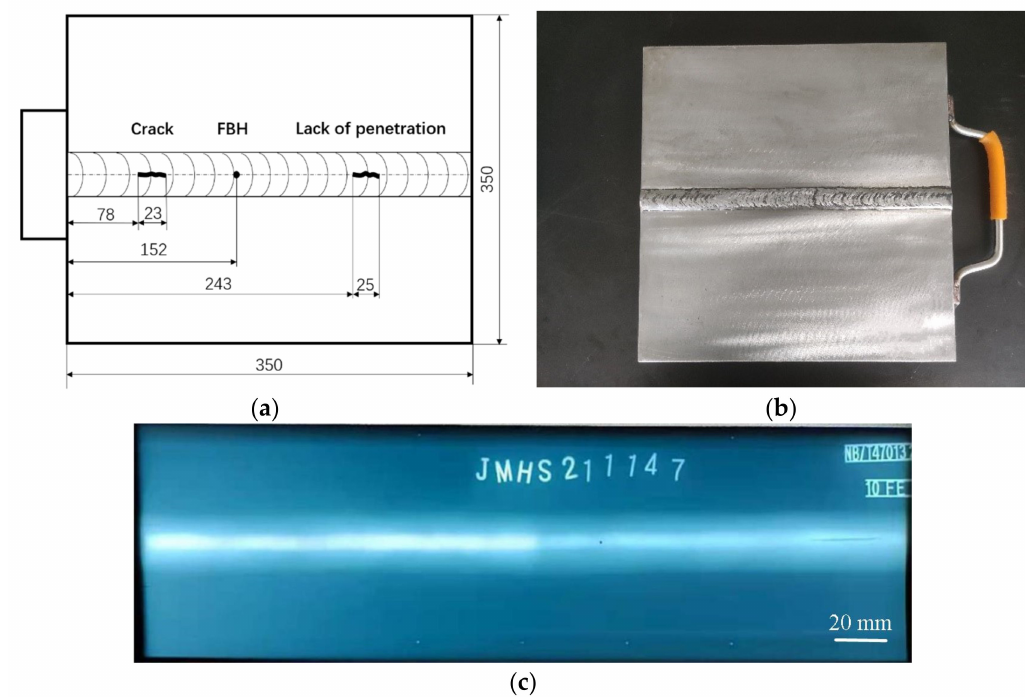
Figure 5. ( a ) Schematic diagram, ( b ) physical picture, and ( c ) RT scanning image of the weld specimen with defects. Note that in ( c ), the crack was not found using the RT method, as it was an area-type flaw.